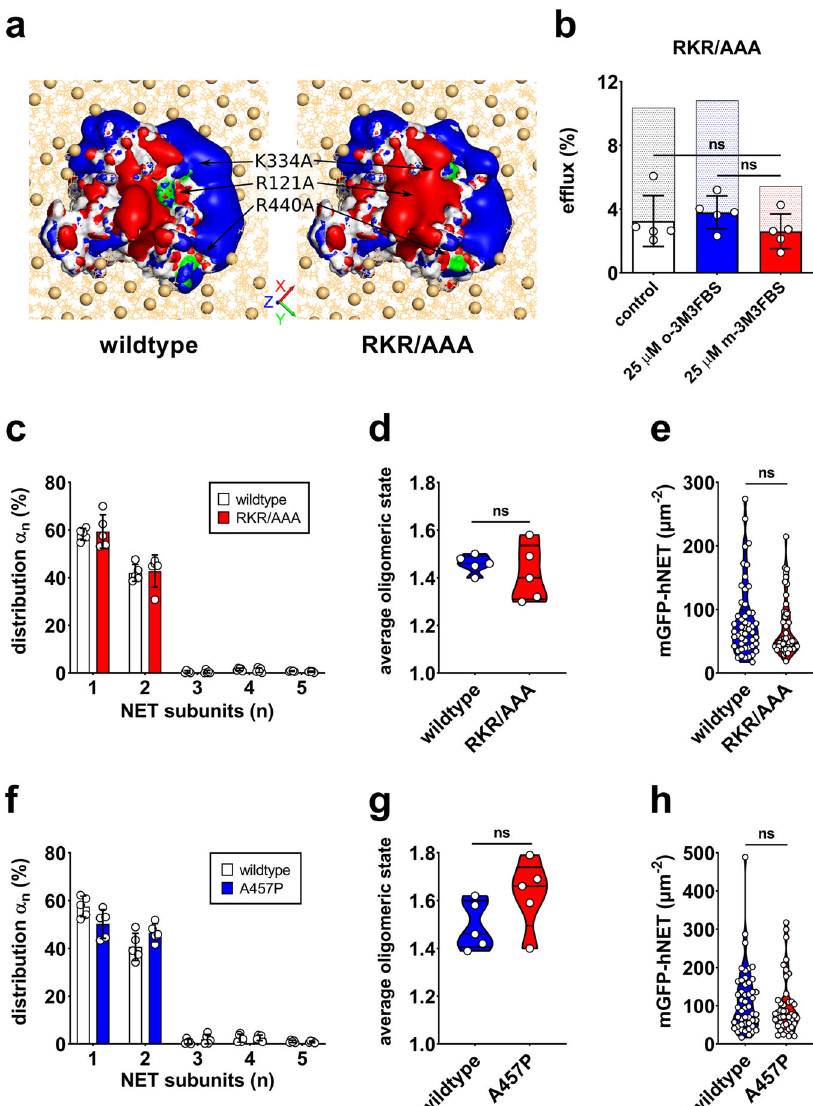
Fig. 4 Subunit stoichiometry and function of the RKR/AAA and A457P mutant. a Electric fi eld of the intracellular side of wildtype and mutant NET. The protein ’ s solvent-accessible surface is shown as white surface except for the residues replaced by the mutation, which are green. Red surface indicates the negative electric isopotential of -2 kT/e while blue surface shows the + 2 kT/e. Possible protein-lipid interactions are depicted by showing the inner lea fl et of a modeled POPC + cholesterol membrane indicated as orange lines and the phosphate headgroups as spheres. b Total d -methamphetamine-induced substrate ef fl ux for the RKR/AAA mutant under PIP 2 -depleted conditions was statistically indifferent from control. Bars represent mean ef fl ux (± SD) of fi ve experiments, normalized to basal ef fl ux. Ef fl ux for wildtype NET is included as shaded bars for comparison. c Subunit distribution of the RKR/AAA mutant. Each data point represents an independent experiment with TOCCSL runs on ten cells. Bars represent means ± SD. d The average oligomeric state of the RKR/AAA mutant was indifferent from wildtype. e NET-RKR/AAA surface densities of the imaged cells did not differ from wildtype NET densities. f Subunit distribution of the A457P mutant. Each data point represents an independent experiment with TOCCSL runs on ten cells. Bars represent means ± SD. g The average oligomeric state of the A457P mutant was indifferent from wildtype. h NET-A457P surface densities of the imaged cells did not differ from wildtype NET